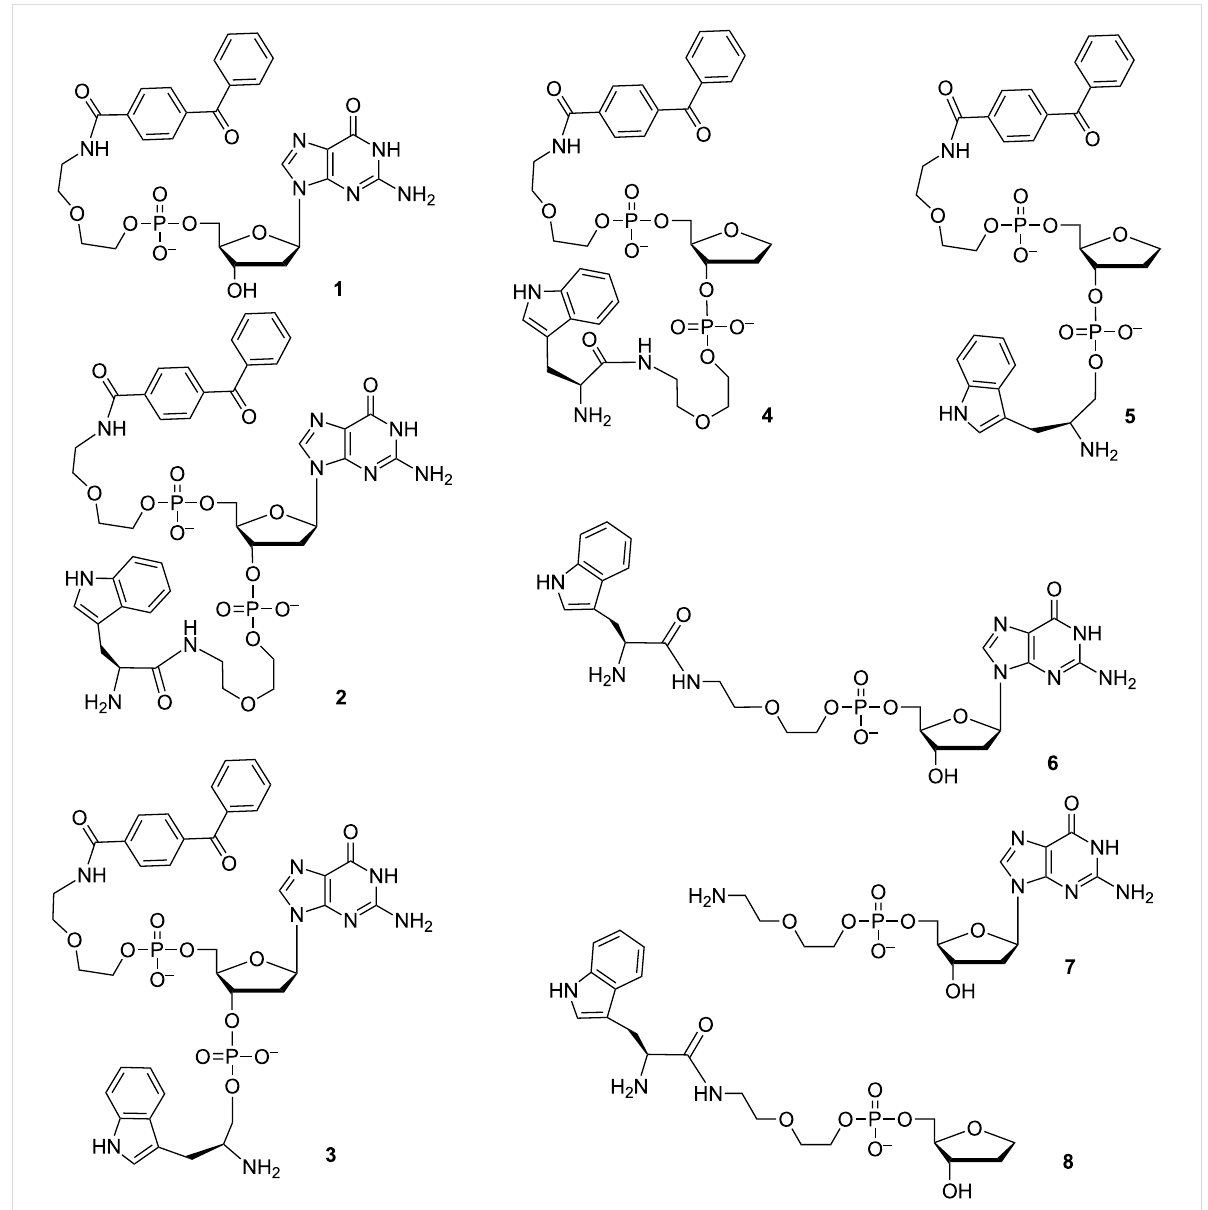
Figure 1: Model compounds for the TR NMR photo-CIDNP experiments: conjugates of 4-benzoylbenzoic acid, 2’-deoxyguanosine, L-tryptophan, and L-tryptophanol.